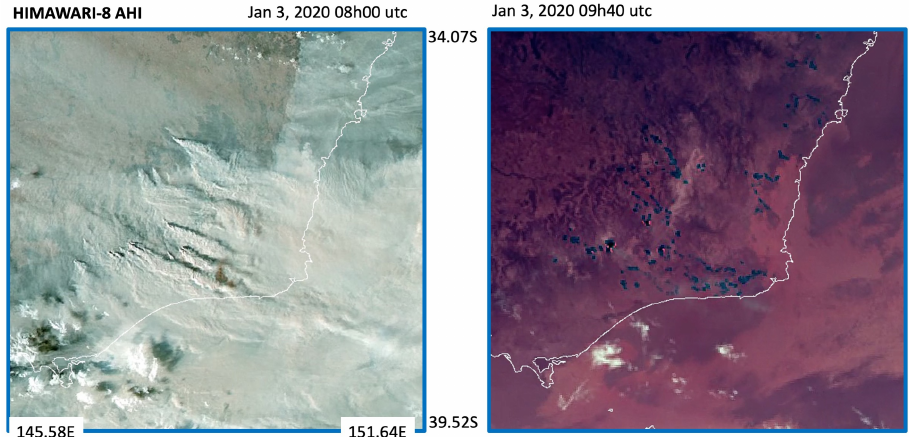
Figure 5. Day and night views of the January 2020 bushfires raging on Victoria region’s eastern coast in Australia, which were captured by Himawari-8 AHI. The fire activity is visible at night as dark/blue spots.